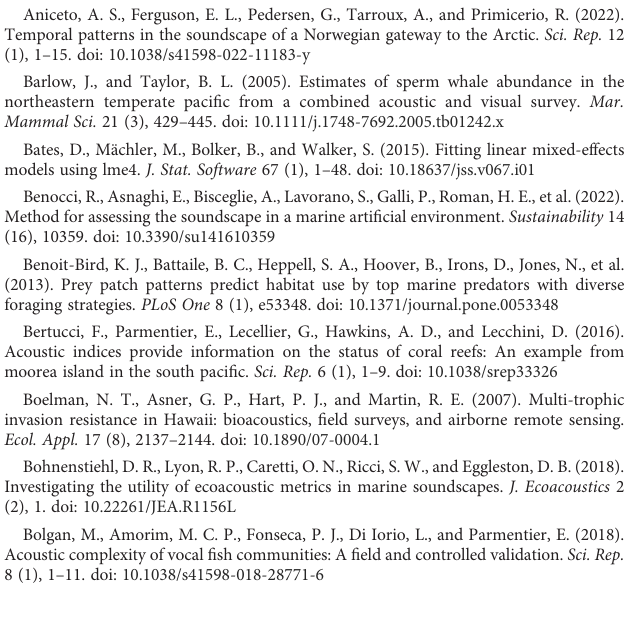
call characteristics at three recorders. SUPPLEMENTARY TABLE 3 Spearman correlation coef fi cient and con fi dence interval results for sperm whale call characteristics for two indices and at two